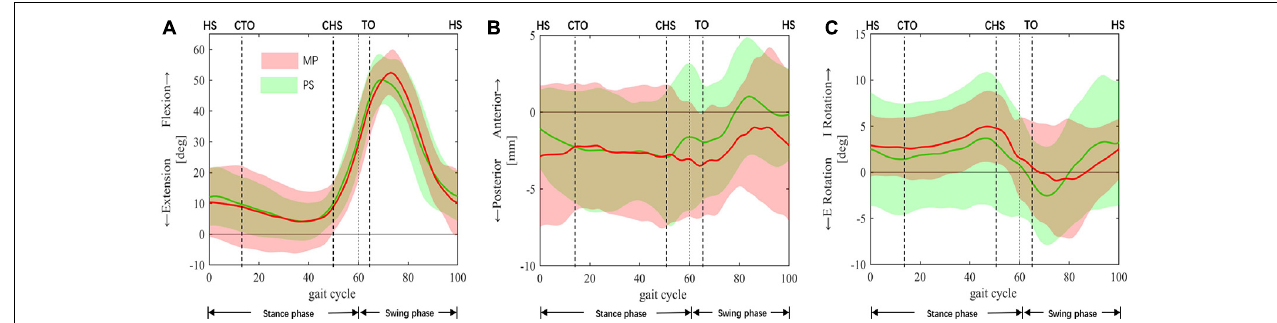
FIGURE 3 | In vivo kinematics of TKA knees. In vivo kinematics of the medial pivot (MP: red color) and the posterior-stabilized (PS: green color) TKAs during a complete gait cycle. (A) Knee Flexion/Extension. (B) Anterior/posterior femoral translation was relative to the tibia. (C) Internal/external tibial rotation was relative to the femur. The means and standard deviations of flexion+/extension–, anterior+/posterior– translations, internal+/external– rotation (I/E rotation), were represented by solid lines and corresponding shaded area. The dashed lines at 60% cut the gait cycle into the stance phase and swing phase. Gait events include HS, heel-strike; CTO, contralateral toe-off; CHS, contralateral heel-strike; TO, toe-off.